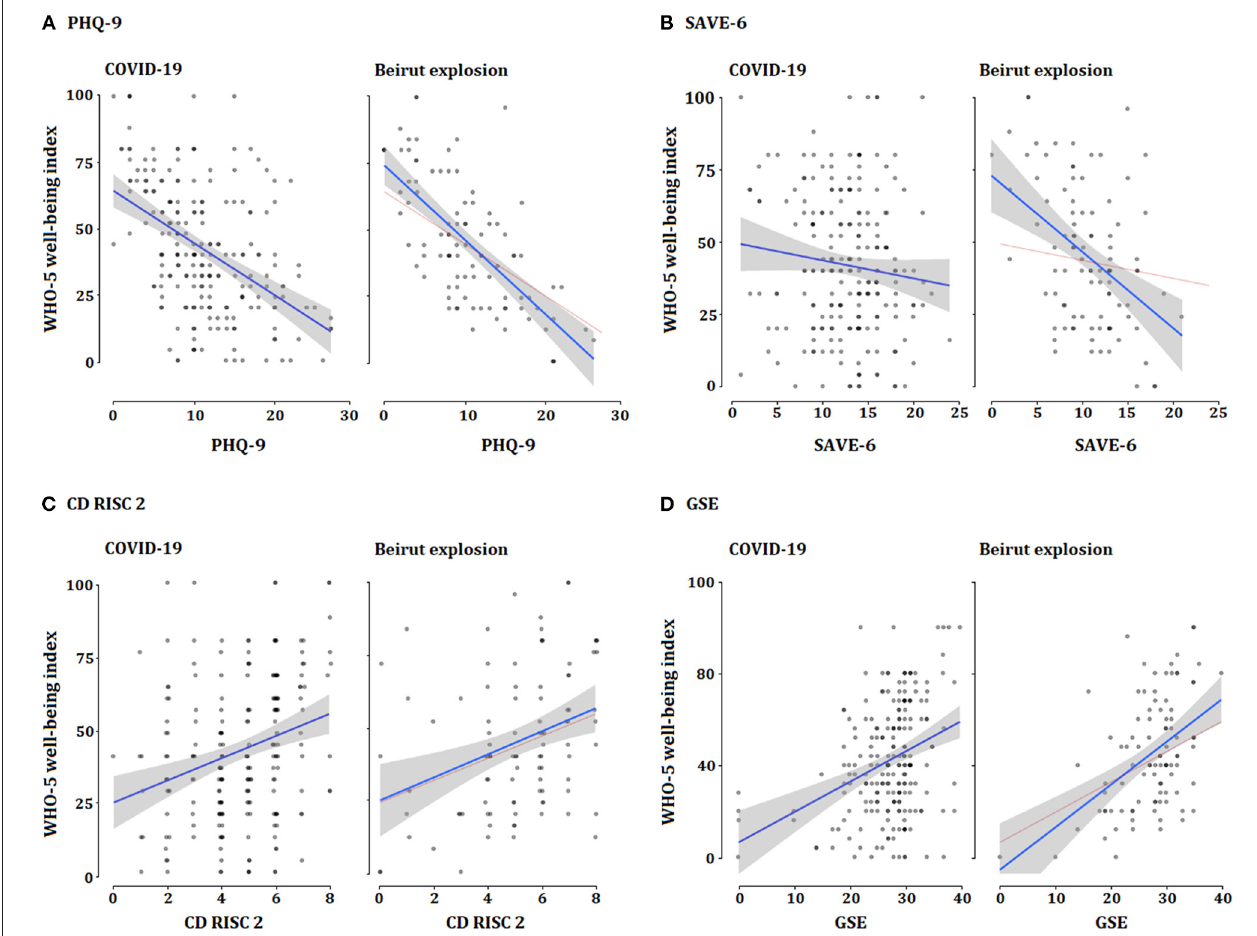
FIGURE 1 | Linear regression analysis of psychological well-being with each rating scale among subjects were answered feeling more stressful to COVID-19 or Beirut explosion. (A) Depression and psychological well-being. (B) Viral anxiety and psychological well-being. (C) Resilience and psychological well-being. (D) Self-efficacy and psychological